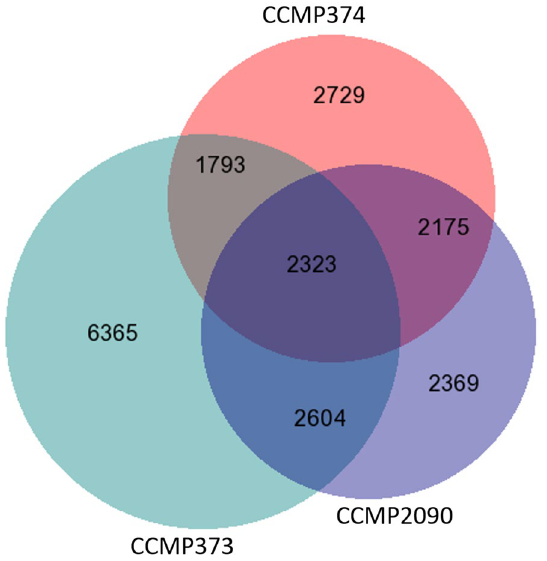
Figure 4. Digital unique expression. Proportional Venn diagram of the genes expressed in each of the strains in exponential growth, and their overlaps. The diagram was drawn using BioVenn (https:// www. biove nn. nl/ index.